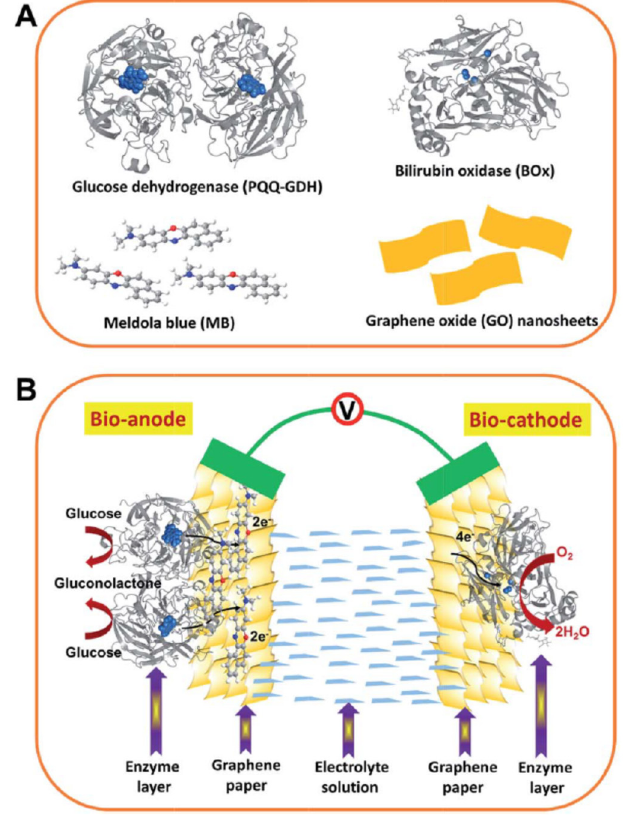
Figure 3. Schematic illustration of (a) the structures of the main building block materials and (b) the assembled enzymatic biofuel cell [48]. Copyright 2019 Royal Society of Chemistry. assembled enzymatic biofuel cell [48]. Copyright 2019 Royal Society of